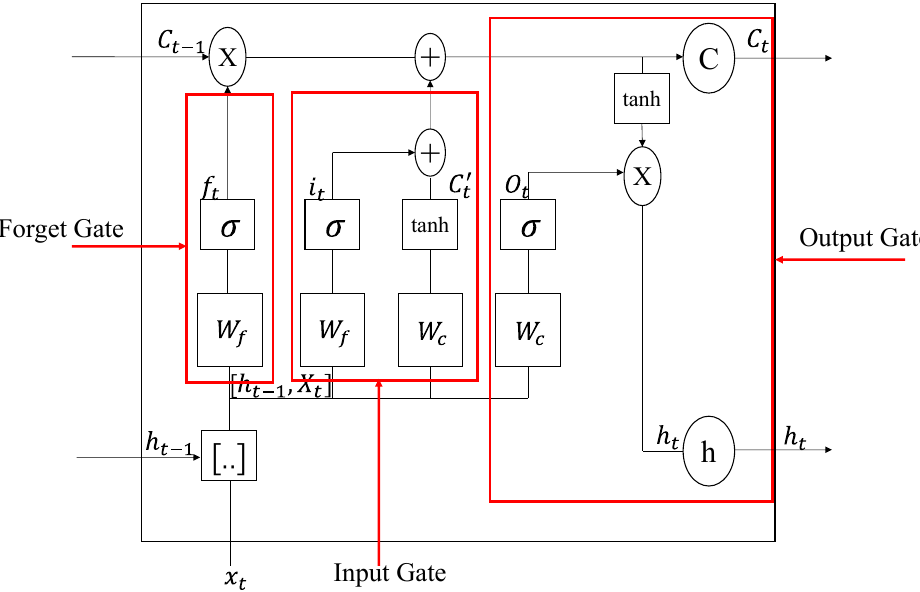
Figure 1. LSTM structural unit diagram. O t in Figure 1 represent the forgetting gate, input gate, output gate,